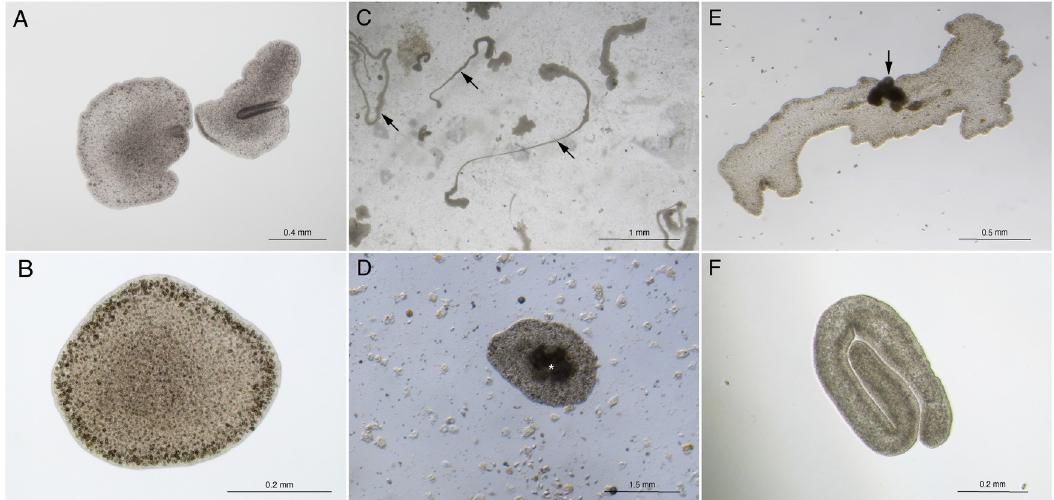
Fig 1. Radiation exposure causes morphological changes in T . adhaerens . (A) Untreated specimens of T . adhaerens , the animal on the right is folding. (B) Magnification of a single untreated T . adhaerens . (C) Sections of the animals can become elongated (arrows), 20 days after 218.6 Gy exposure. (D) Dark tissue mass (asterisk) in the middle of what is either a small animal or extrusion, 70 days after 143.6 Gy exposure. (E) Dark tissue mass projecting from the dorsal epithelium (arrow) of a T . adhaerens , 82 days after 143.6 Gy exposure. (F) A folded T . adhaerens that is not moving, 36 days after 80 Gy exposure; this animal eventually